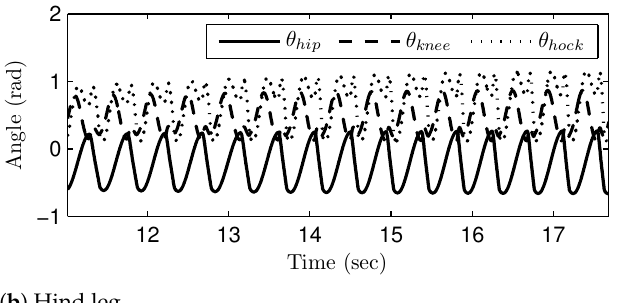
Figure 18. The join-angle trajectories when the gait phase is changed from the transverse gallop to rotatory gallop: ( a ) front leg and ( b ) hind leg.